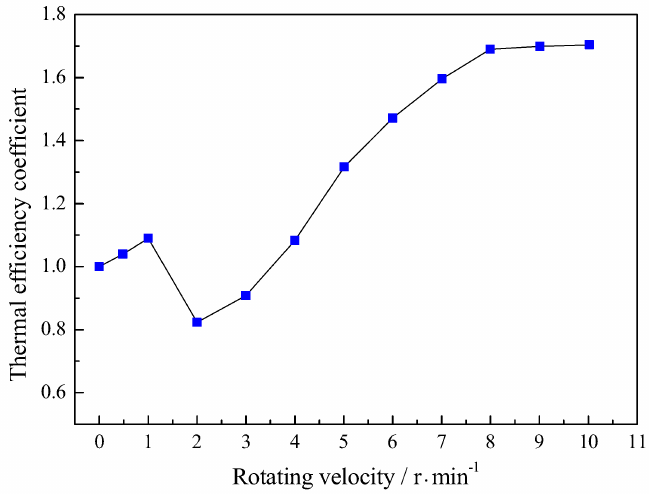
Figure 21. Comparison of thermal efficiency coefficients from experimental and numerical simulation results with rotating wind